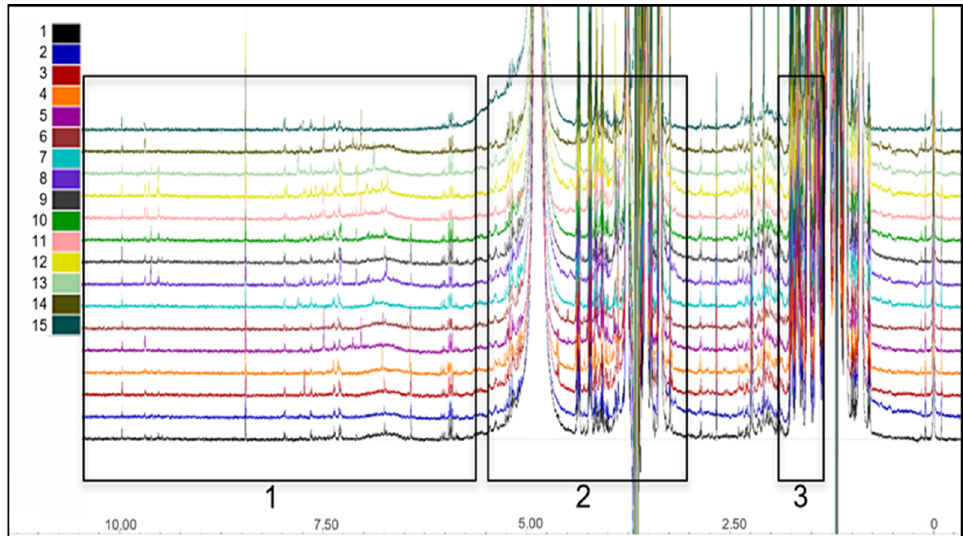
Figure 3. 1 H-NMR stacked spectra of all samples. In box 1, signals related to aromatics; in box 2, signals related to carbohydrates; in box 3, signals related to higher alcohols. For the numbering of the spectra presented in the figure, refer to Table 1.